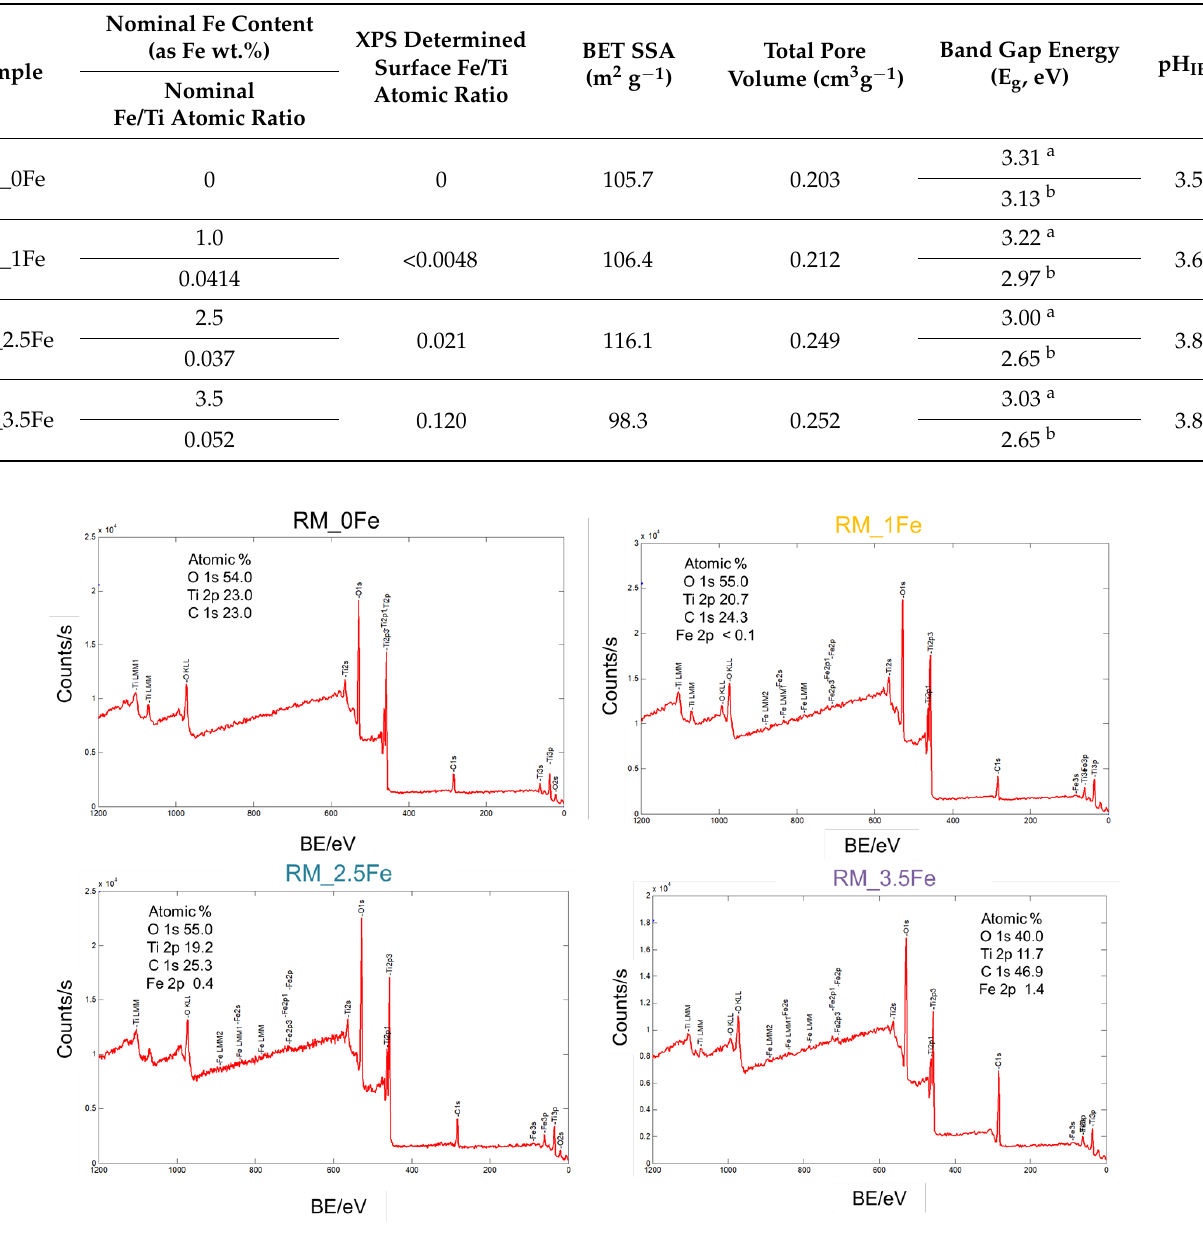
Table 2. Nominal Fe content (wt.%), nominal Fe/Ti atomic ratio and surface Fe/Ti atomic ratio (as determined by the survey XP Spectra in Figure 5); BET SSA and total pore volume, as obtained by N 2 isotherms at − 196 ◦ C; band gap energy (Eg, eV) as obtained by linear extrapolation of the absorption edge (a) and by applying the Tauc’s plot method for indirect band gap semiconductors (b, Figure 5); pH IEP values as determined by electrophoretic measurements.